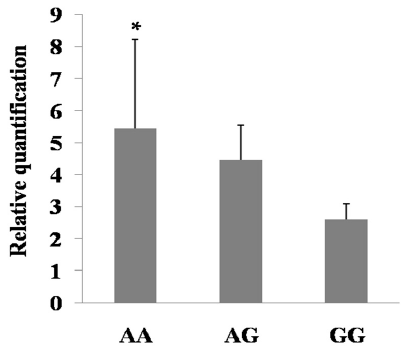
Figure 6. mRNA expression of c.-724 A>G among the different genotypes in the mammary gland of lactating Holstein cows.Bars represent mean ± SE ( n = 5, 2, and 1, respectively). * p < 0.05.